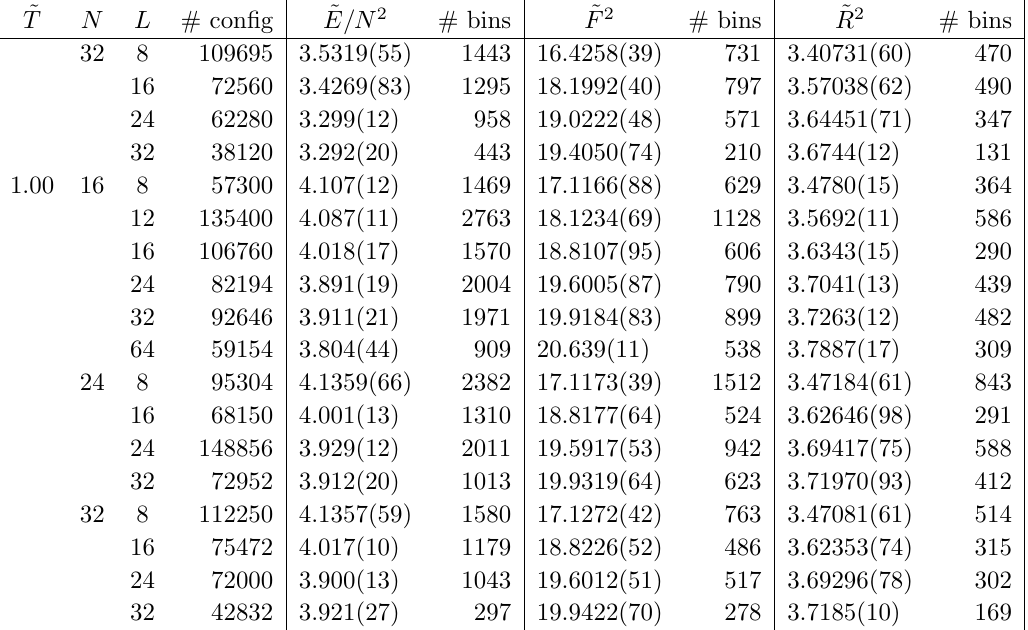
Table 8. Summary table for the parameters and expectation values of observables in the full ungauged matrix model. When the expectation value of an observable is not shown, it means that the autocorrelation time estimation was not robust enough given the accumulated